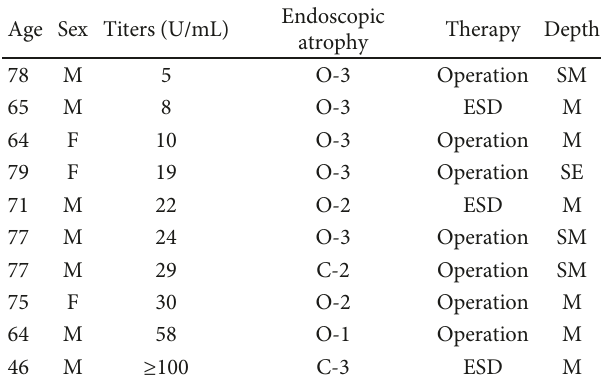
Table 2: Details about the 10 patients in whom GC was